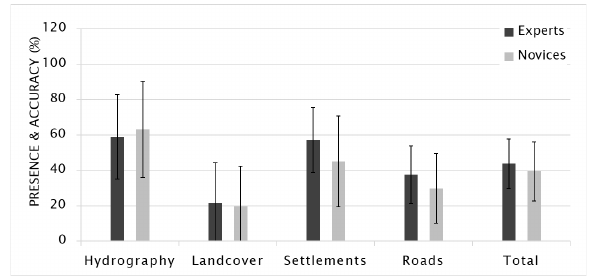
Figure 8. Presence and accuracy scores (Error bars indicate SD).